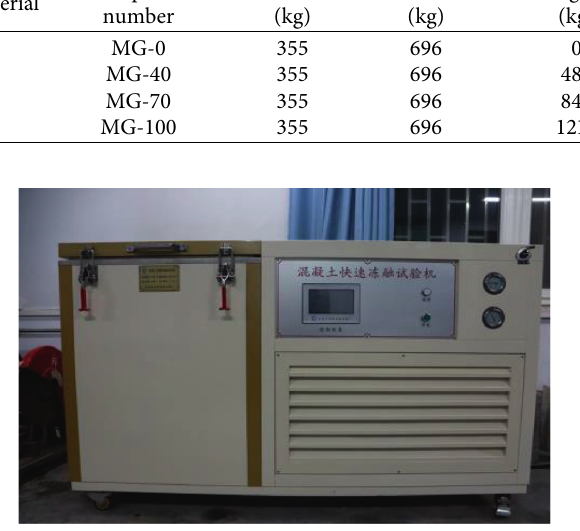
Figure 1: Concrete freeze-thaw cycle machine.